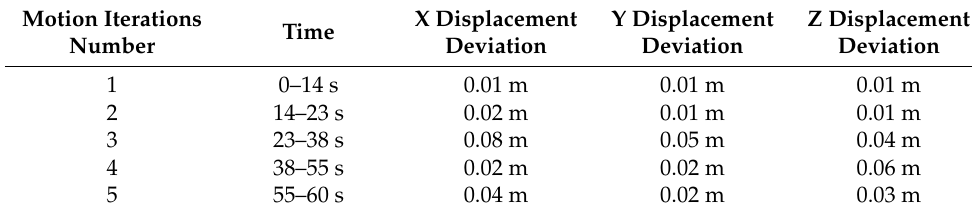
Figure 13. Comparison of expected and actual displacement in the Z-direction of base truss crawling. The process motion error statistics are shown in Table 5. In the time period from 0 s to 23 s, the space robot position tracking effect is very good, and the displacement deviation in all three directions of XYZ is less than 0.02 m. Table 5. Joist crawling substrate motion status table.